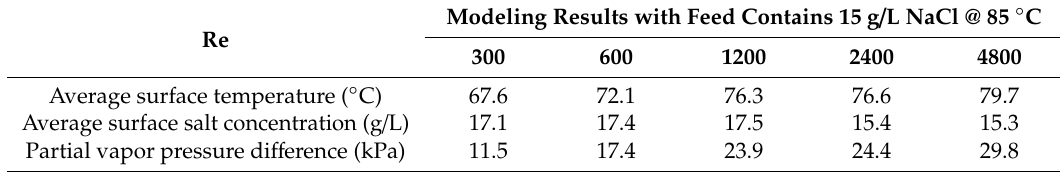
Figure 6. The impact of feed crossflow Reynolds number on PVD system performance at 85 °C with 15 g / L NaCl solution and permeate vacuum of 0.85 bar. The blue bars represent permeate flux ( y -axis on the left) and the red triangle dots represent salt rejection ( y -axis on the right). Table 3. Simulation results of parameters values with di ff erent